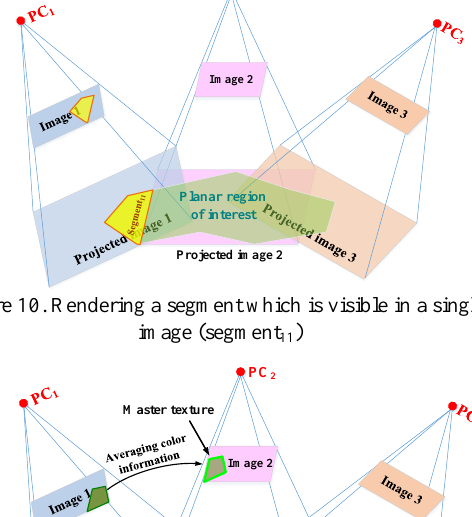
Figure 12. Filtering methods for adapting a texture image to the screen